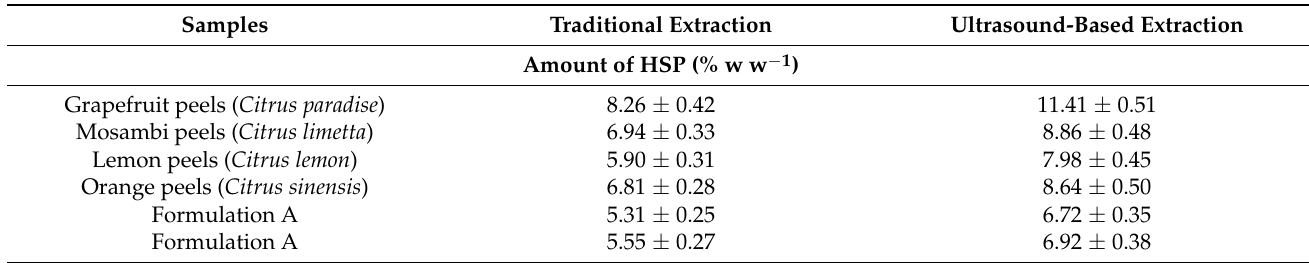
Table 6. Application of a sustainable RP-HPTLC method for the quantitative estimation of HSP in TE and UBE of four different varieties of citrus fruit peels and commercial formulations (mean ± SD; n = 3).